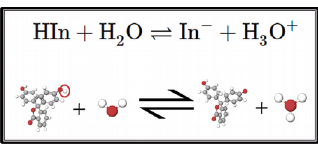
Figure 5. Equilibrium of phenolphthalein in aqueous solution (Moore et al.,